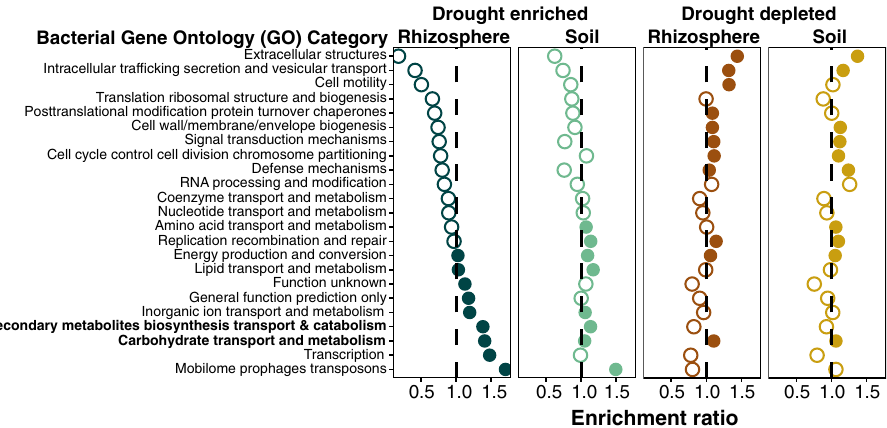
Fig. 2 Bacterial gene functional capacity enrichment in rhizosphere and soil under drought. Bacteria gene ontology (GO) enrichment analysis for all genes derived from co-assembled contigs showing enrichment (panels one and two) or depletion (panels three and four) under drought for rhizospheres or soils at the peak of drought (TP8). The values on the x -axis indicate the fold enrichment ratio of the relative percentages of genes that are upregulated or downregulated under drought in each category relative to the total relative percentage of genes in the corresponding category within the entire dataset. Categories for which there were fewer than fi ve differentially expressed genes were omitted. Solid circles indicate that the enrichment was signi fi cant ( p -value of < = 0.05) in a one-sided hypergeometric test. Two categories discussed in more detail in the Results are shown in